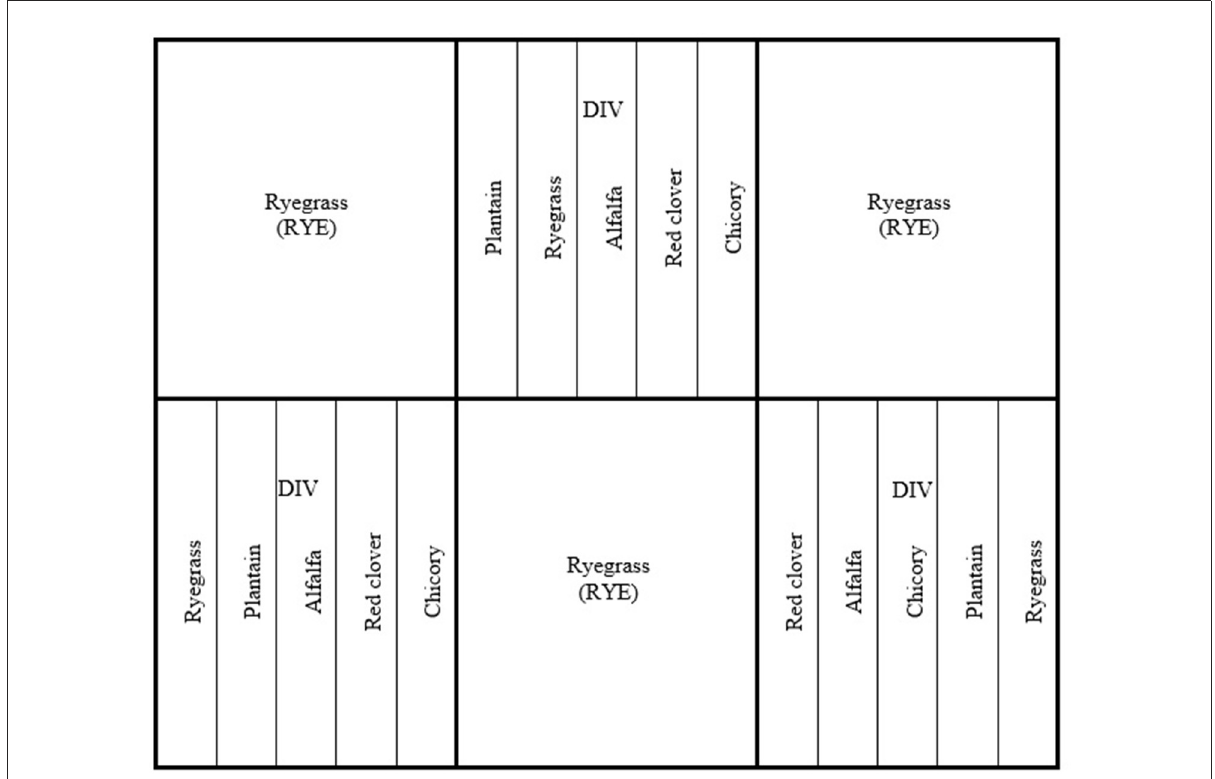
FIGURE1 Experimental area and paddock layout grazed by ewes with access to only ryegrass ( Lolium perenne L.; RYE) or ewes allocated a diverse diet (DIV) of spatially separated strips of equal area, of chicory [ryegrass, chicory ( Cichorium intybus L.), alfalfa ( Medicago sativa L.), plantain ( Plantago lanceolata L.), and red clover ( Trifolium pretense